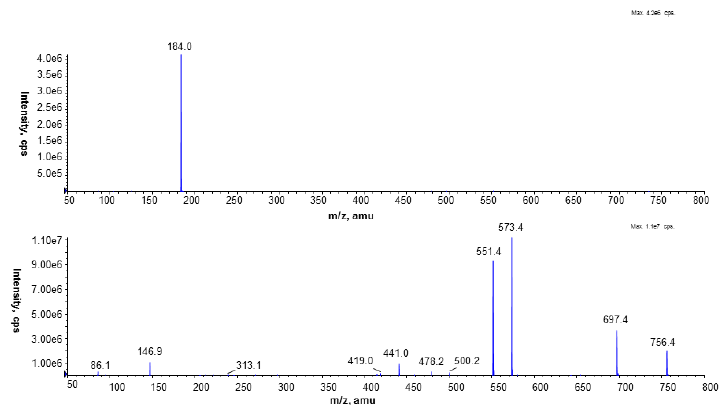
Figure 4. CID spectrum of the PC standard (1,2-dipalmitoyl-sn-glycero-3-phosphocholine) of protonated (top) and sodiated (below) molecules, recorded under NP LC/MS conditions (phase A—hexane/isopropanol (3:2, v / v ) and phase B—an isopropanol/hexane/5 mM aqua solution of ammonium acetate (38:56:5, v / v / v ). The following elution program was employed: from 53% B to 80% B for 23 min, 80% B maintained for 4 min, 80% B to 100% B for 9 min and 100% B maintained for 14 min. The flow rate was 1 mL/min) in the positive ion MS